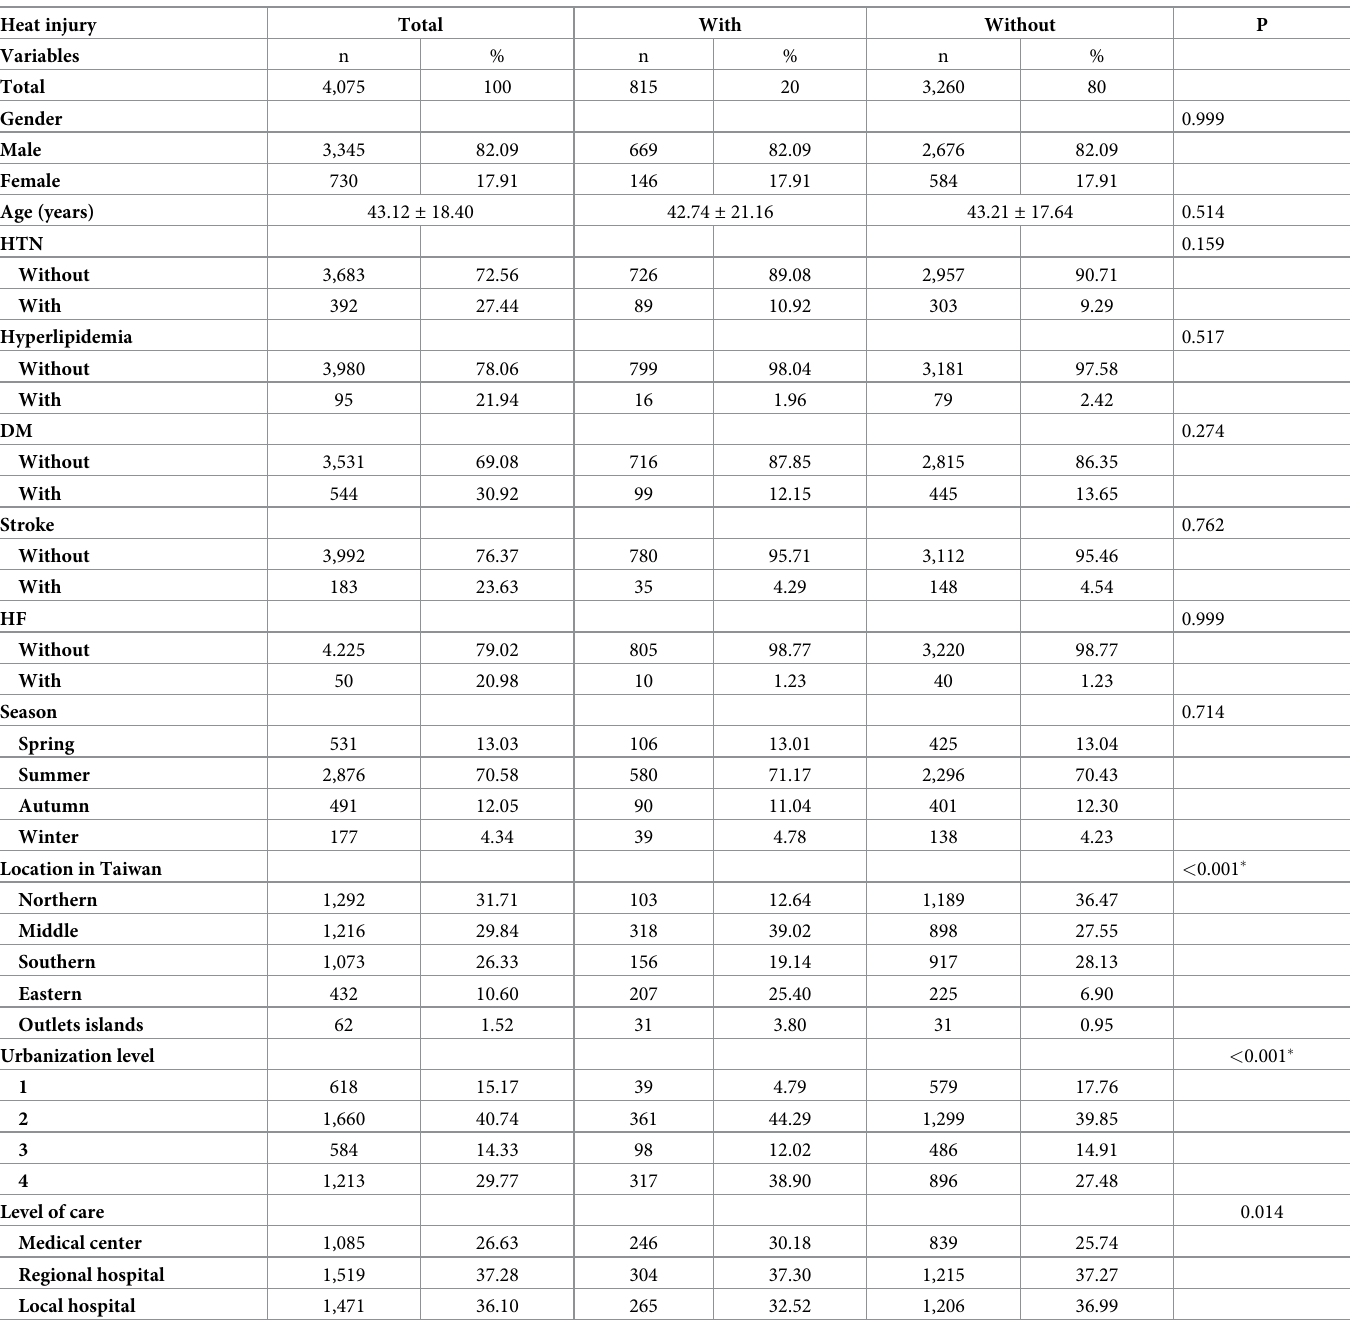
Table 1. Characteristics of study in the